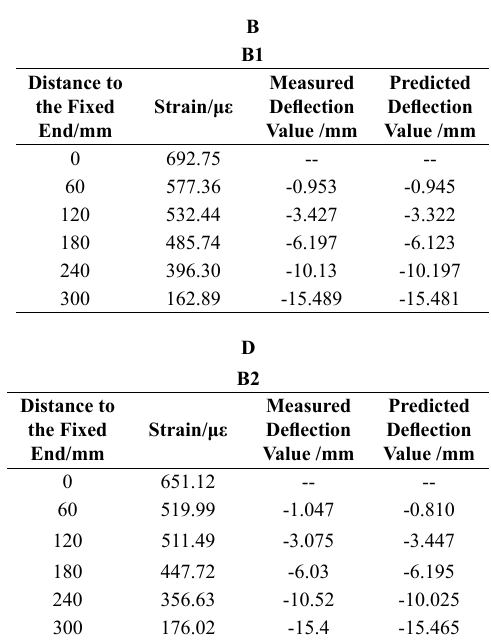
Figure 5. Experimental System of the Strain-based CFRP Laminate Deformation Reconstruction. a Schematic Diagram of the Experimental System,b Site Map of Experimental System,c Paste Position of the FBG Table 2. Comparison of Measured Deflection Values and Predicted Deflection Values of the Test Pieces. A~D Measured Deflection Value and Predicted Deflection Value of Test Piece A1 、 B1 、 A2 、 B2, respectively